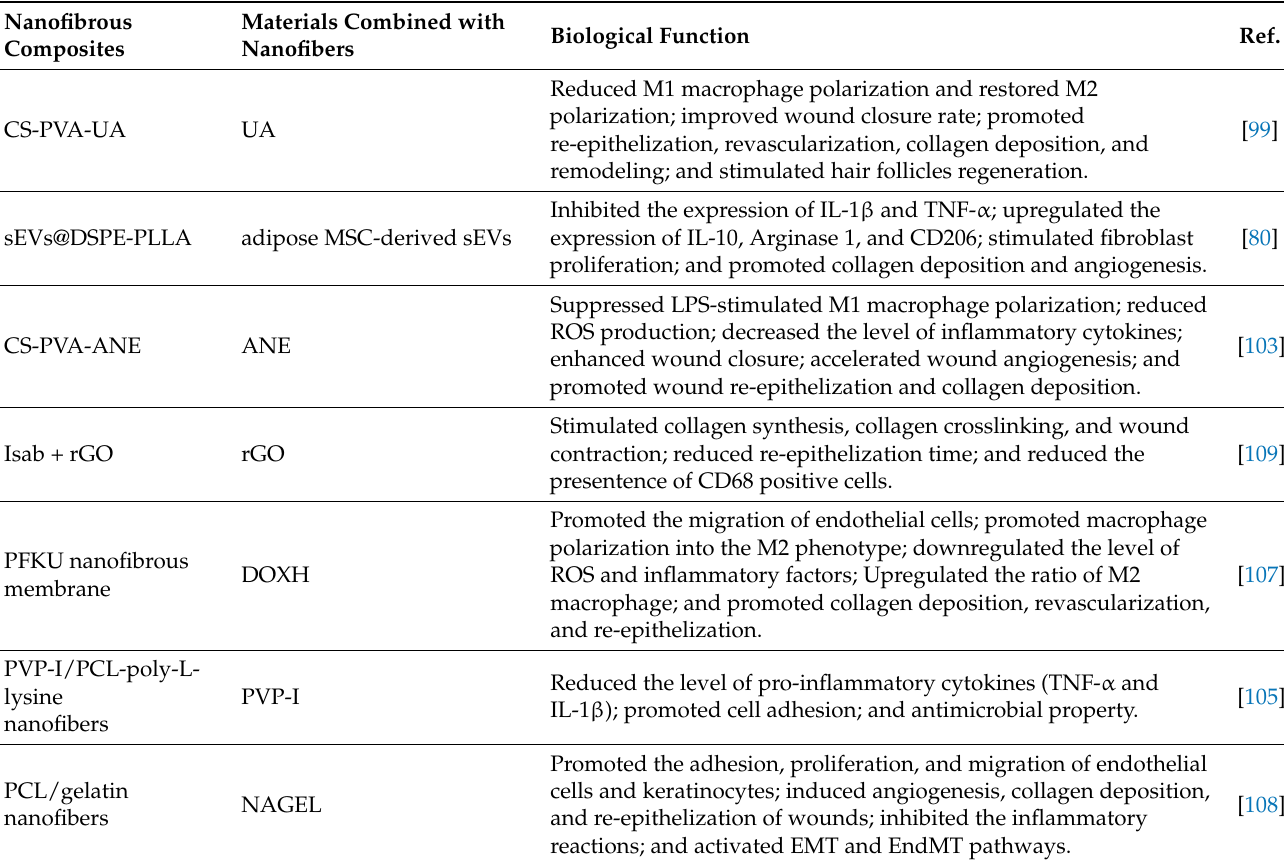
Table 2. Nanofibrous composites to modulate macrophage function for wound